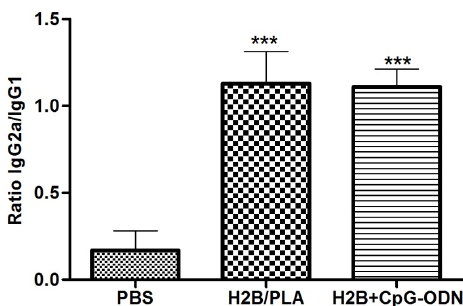
Figure 6. IgG isotype ratio in pooled sera from immunized mice. Results are represented as mean ± standard deviation (SD) of optical density (O.D.) values obtained from 5 mice per group. (***) p < 0.001 between PBS control and protein-received groups.